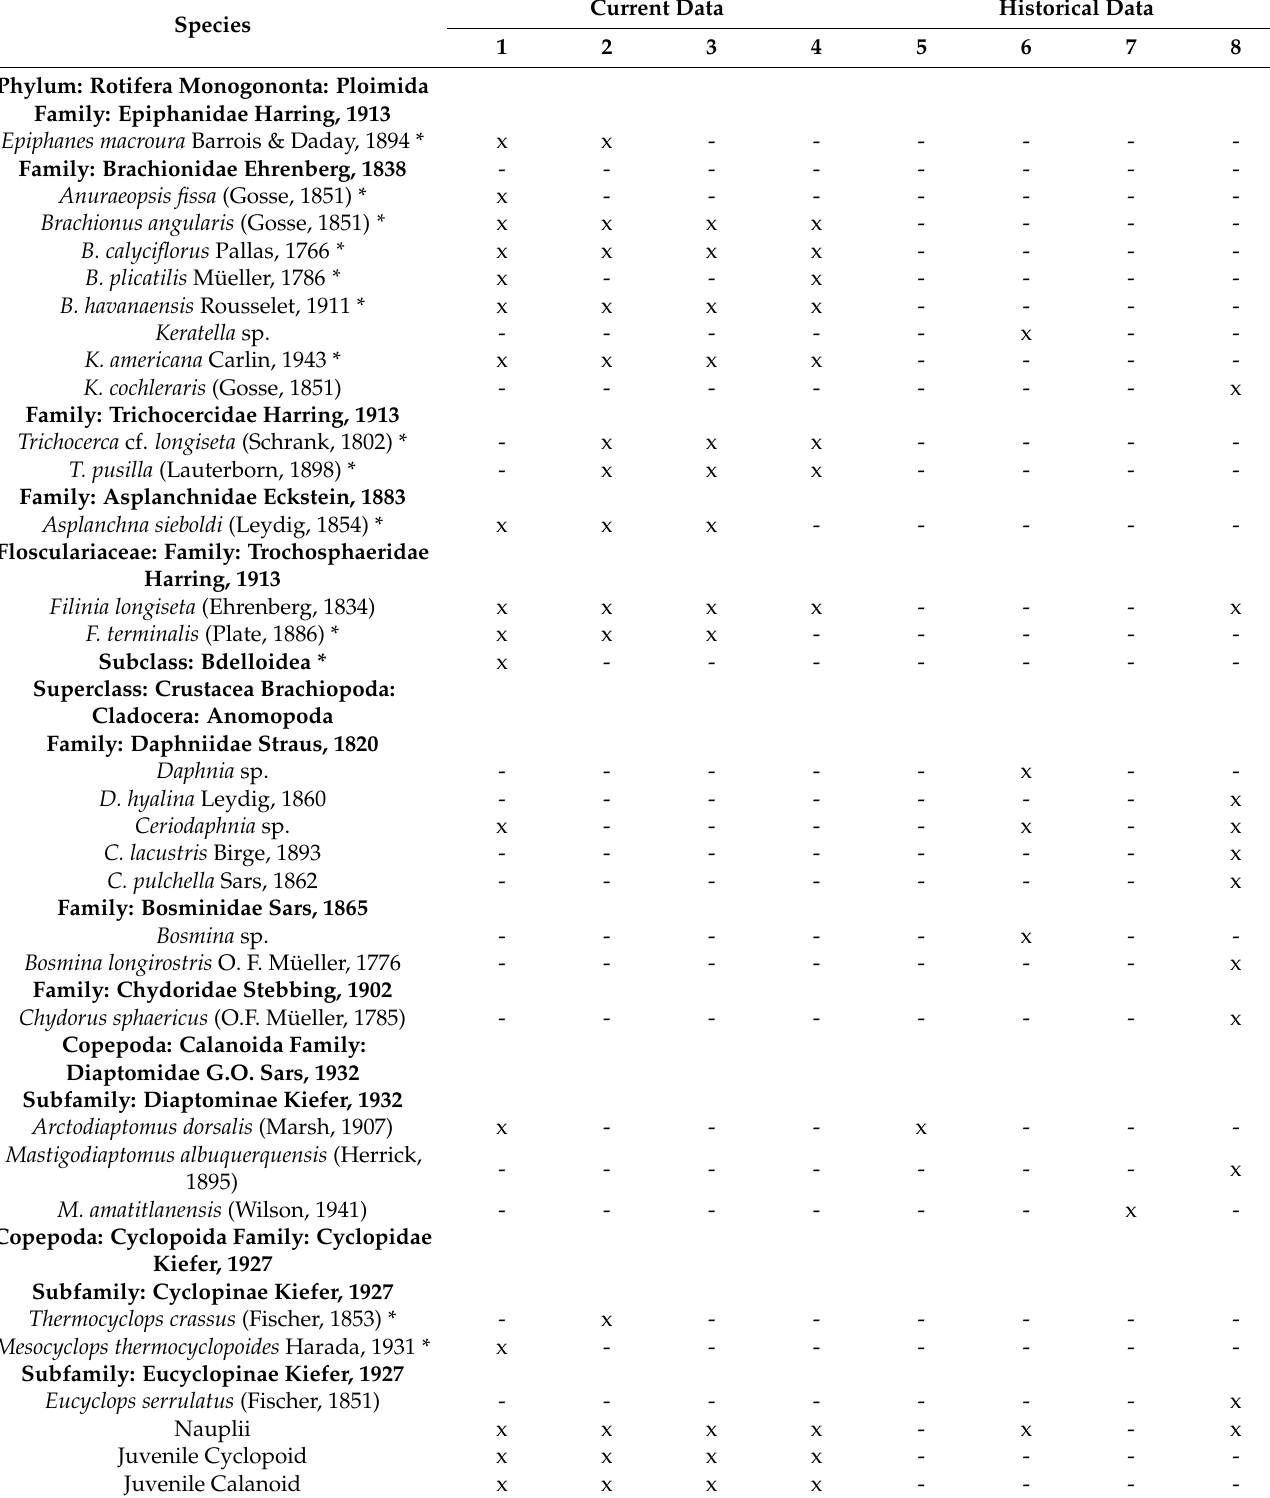
Table 1. Current and historical records of zooplankton species richness in Lake Amatitl á n. Currently recorded species are shown in columns (1) EC, (2) OC, (3) BPO, and (4) MICH. Historical records are shown in columns 5–8, following data by Brandorff (2012) [11]; Basterrechea-D í az (1997) [7]; Wilson (1941) [25]; and Juday (1915) [24], respectively. Presence (x), absence (-), new records (*).